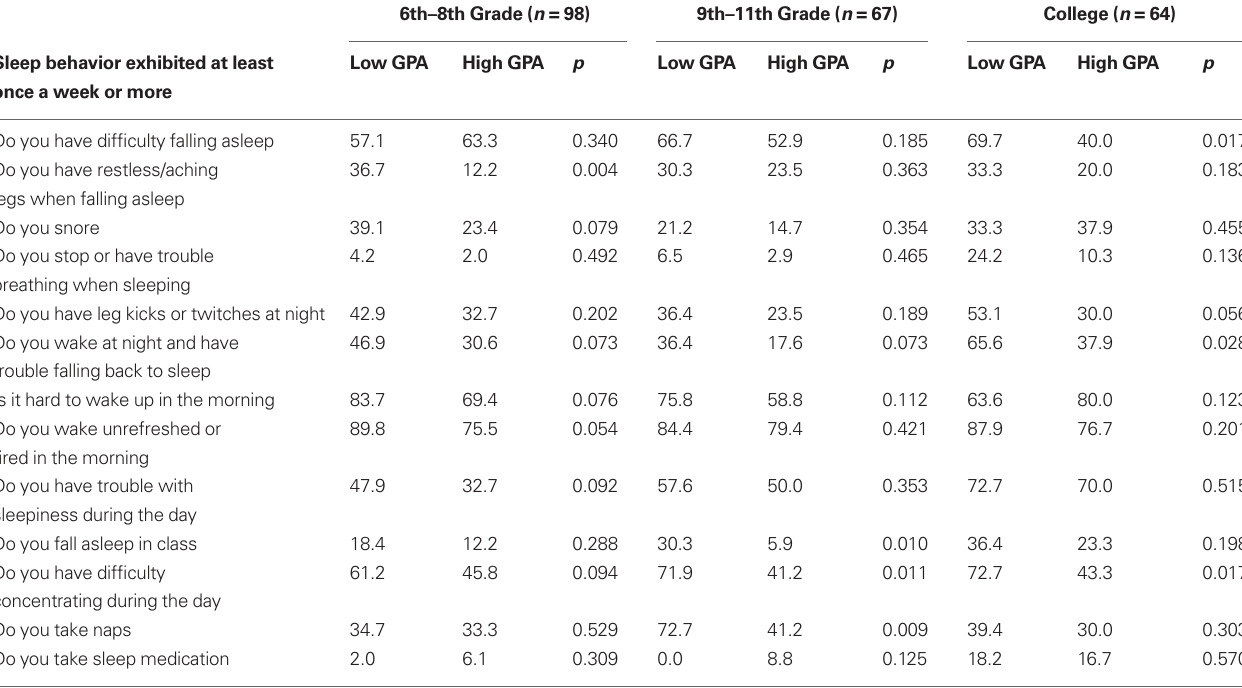
Table 2 | Percent among low and high GPA groups exhibiting sleep behaviors at three levels of education 1